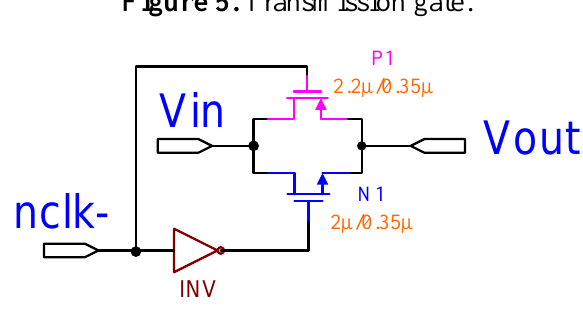
Figure 5. Transmission gate.